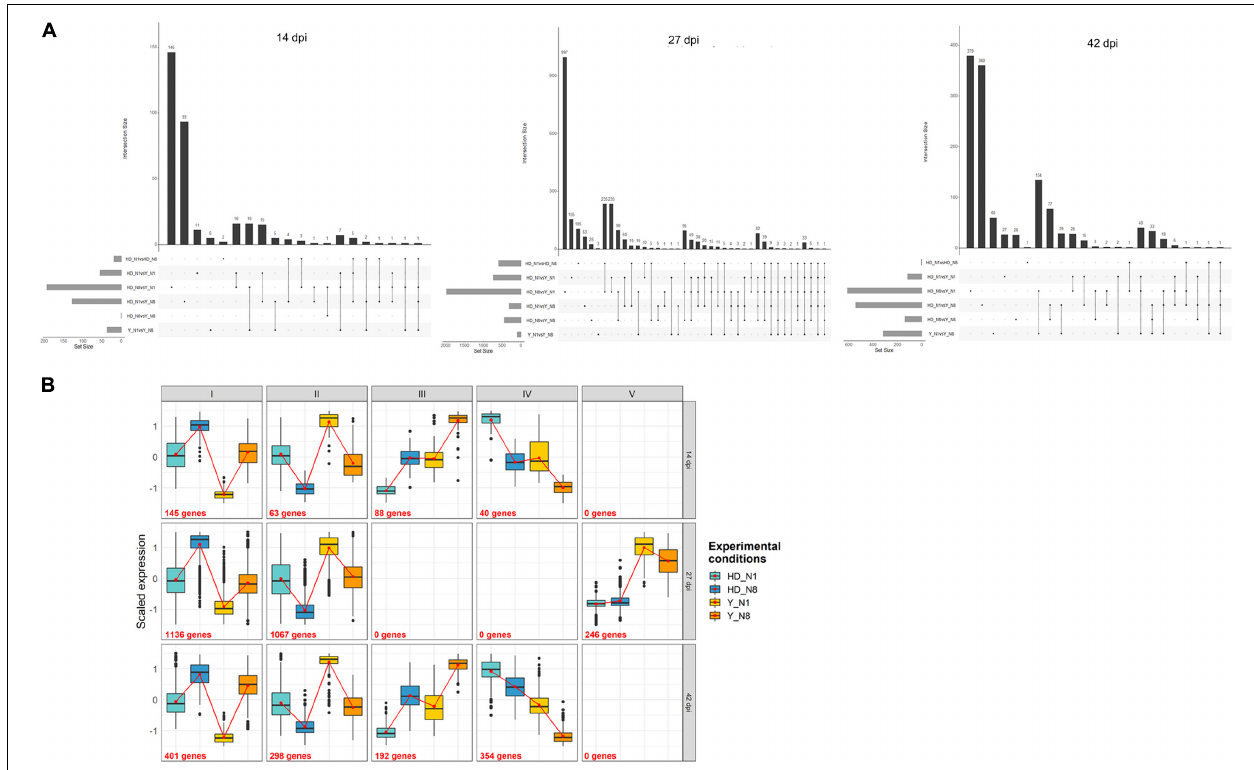
FIGURE 2 | Global view of Plasmodiophora brassicae transcriptome profiles at the three time-course points. (A) Plot of intersections between sets of DEGs. The intersected lists of DEGs and their sizes (number of DEGs) are presented in the horizontal bars on the left. The connected lines among the lists represent their intersections. The vertical bars and associated numbers correspond to specific overlap of DEGs sets. The significance of gene expression changes was inferred based on an adjusted p -value < 0.05. (B) Co-expression clusters. CoSeq package was used to cluster expression data. The number of genes assigned to a particular cluster is indicated with the cluster name. Y -axis represents, for each gene, the number of centered reduced counts (previously filtered and normalized with EdgeR). DEGs, differentially expressed genes; Y, Yudal; HD, HD-018; N1, 1 mM N supply; N8, 8 mM N